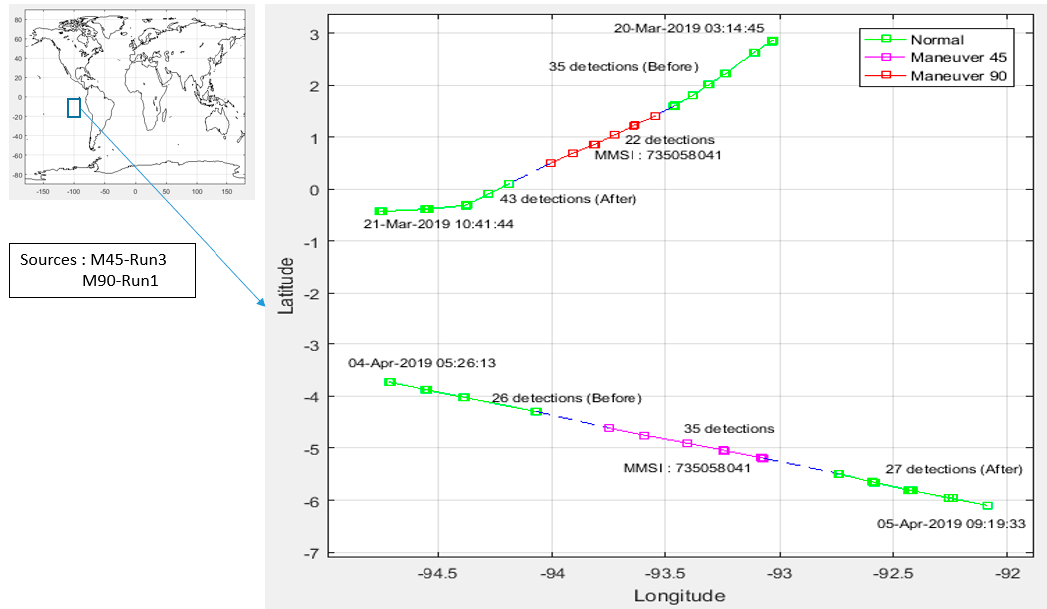
Figure 15. Class A sample of ship tracking in an area of 100% re-detection probability. Appl. Sci. 2019 , 9 , x FOR PEER REVIEW